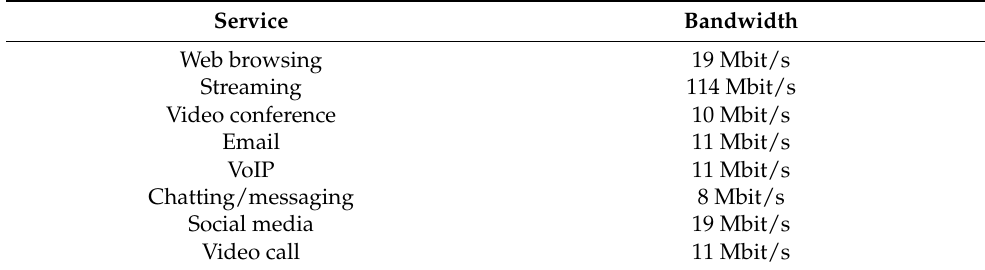
Table 1. Bandwidth per service [20] used in this